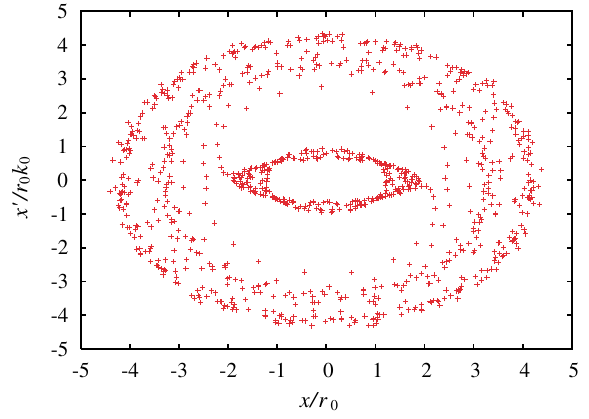
FIG. 10. (Color) Stroboscopic plot for a single particle with (cid:3) 1 : 2 , 1% rms error, and 1000 zero-current betatron x (cid:4) 0 (cid:5) =r 0 periods.